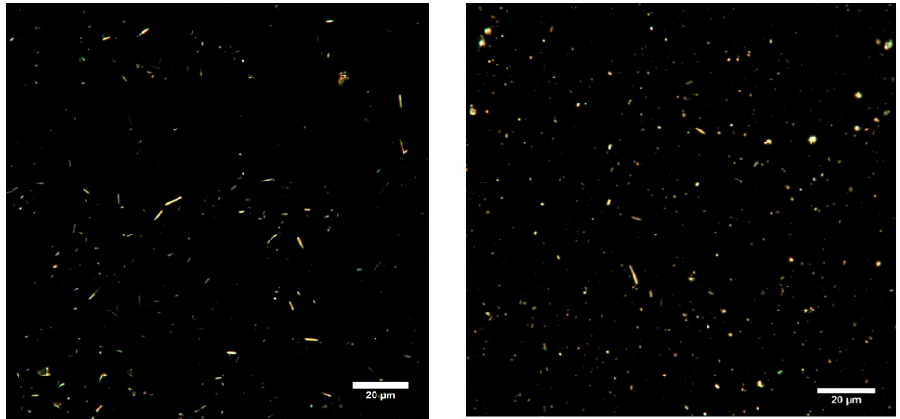
Figure 5. DF optical images of HNTs ( left ) and HNTs/Ca(OH) 2 ( right ) with calcium phosphate end-stoppers in water.